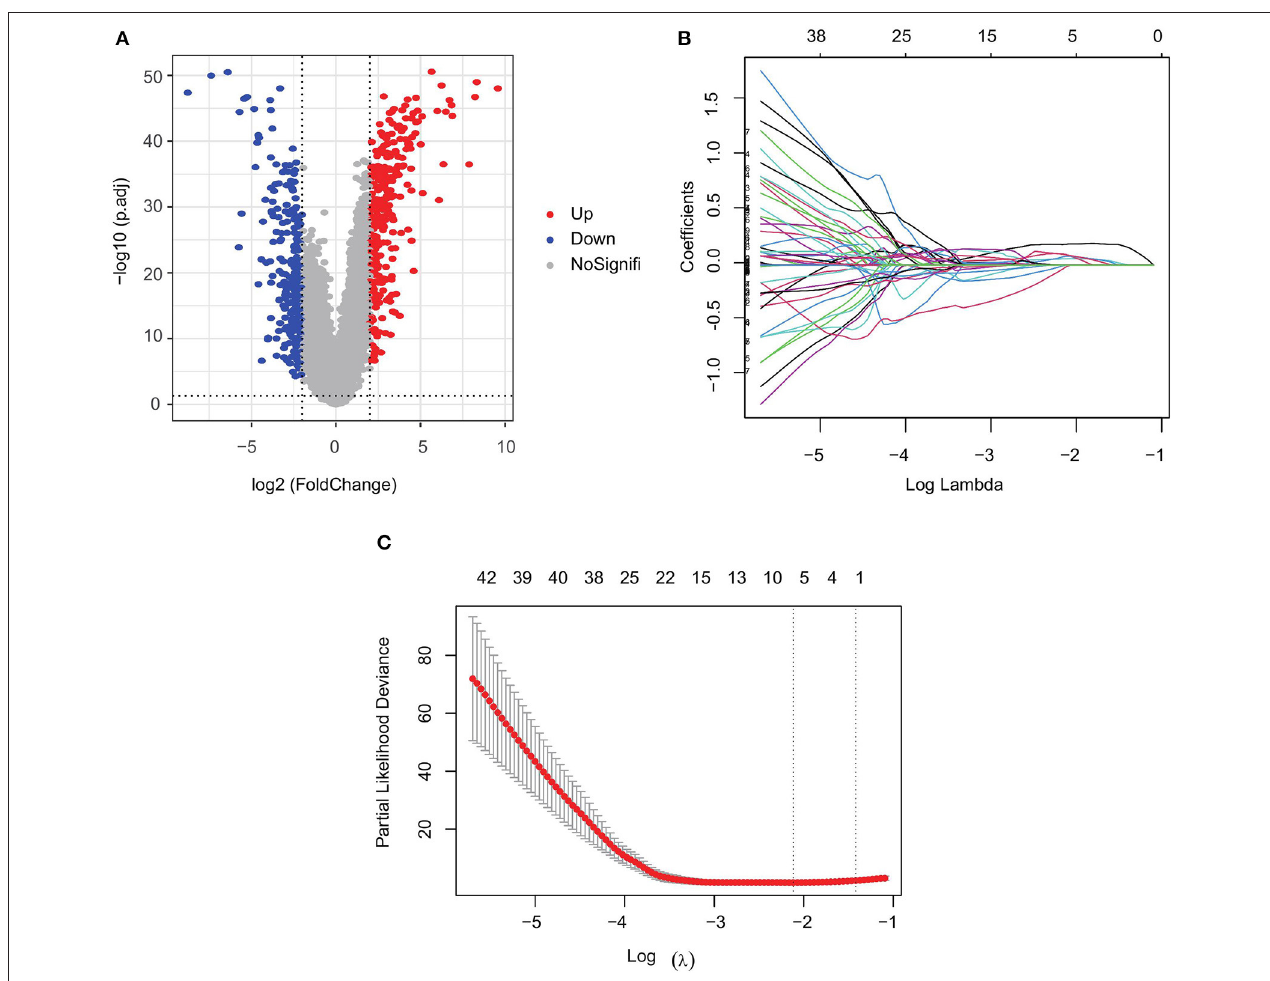
FIGURE 2 | Screening of prognostic genes for bone metastases. (A) Differentially expressed genes in PRAD bone metastasis and in situ PRAD; (B) regression coefficients of each gene in Lasso Cox regression analysis, with certificates representing positive correlations and collaterals representing negative correlations; and (C) selection of the best parameter λ in Lasso